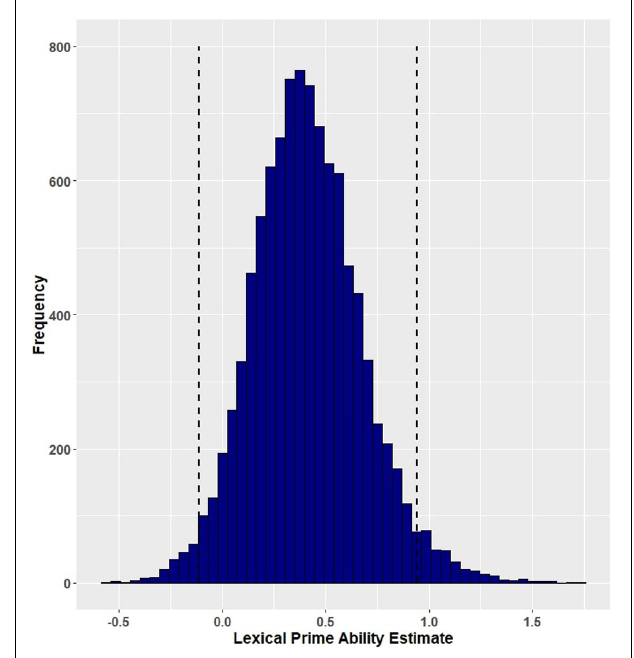
FIGURE 6 | Posterior distribution and 95% highest density intervals (HDIs) of the fixed effect of lexical co-occurrence facilitation from Model 3 (primed accuracy for participants with aphasia). Dashed lines mark the 95% highest density intervals (HDIs) for the posterior